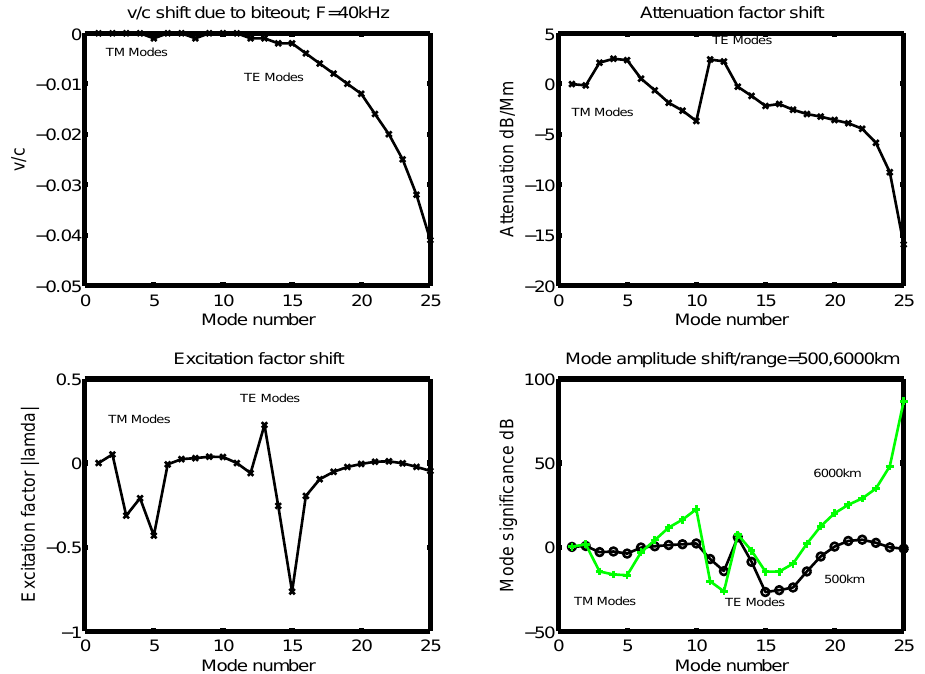
Fig. 5. Shifts in modal parameters at f =40kHz. Dominant modes are TM2–TM4. TE15 is of significance at short range and TE12–13 at longer ranges. Important features are increased attenuation and lower excitation for dominant modes TM3–TM5 and